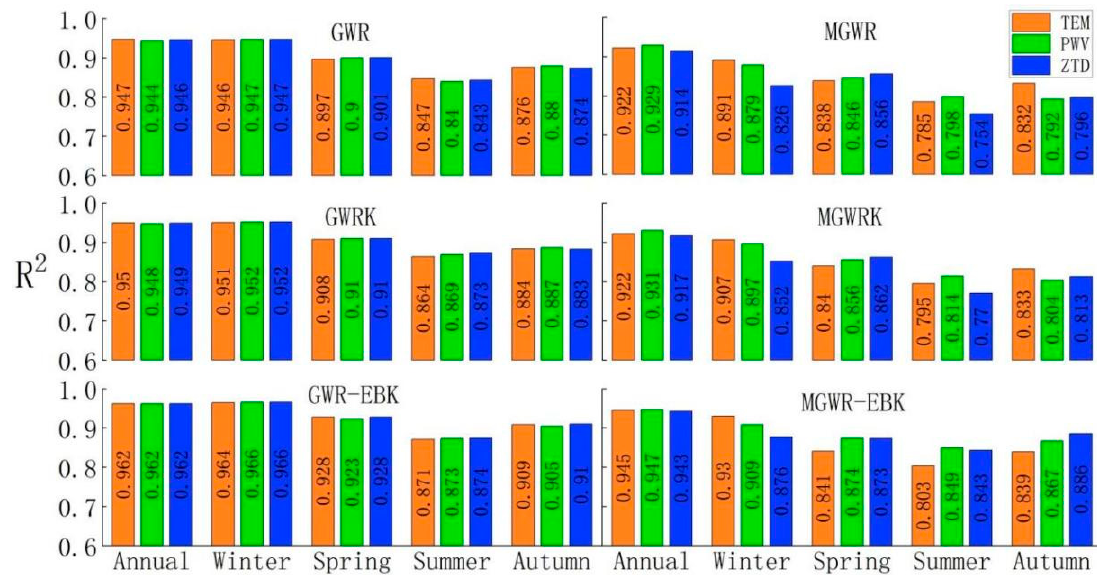
Figure 11. Models’ R 2 values.